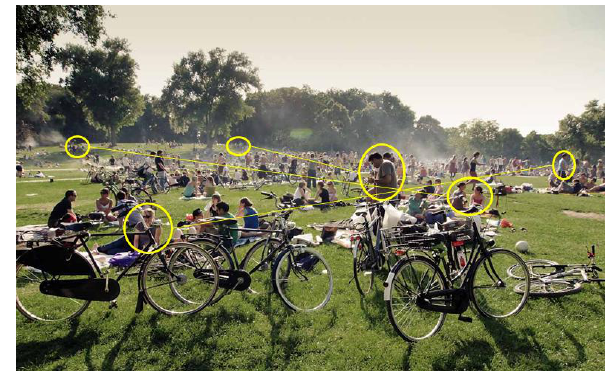
Figure 2. Potential interactions scenario in a